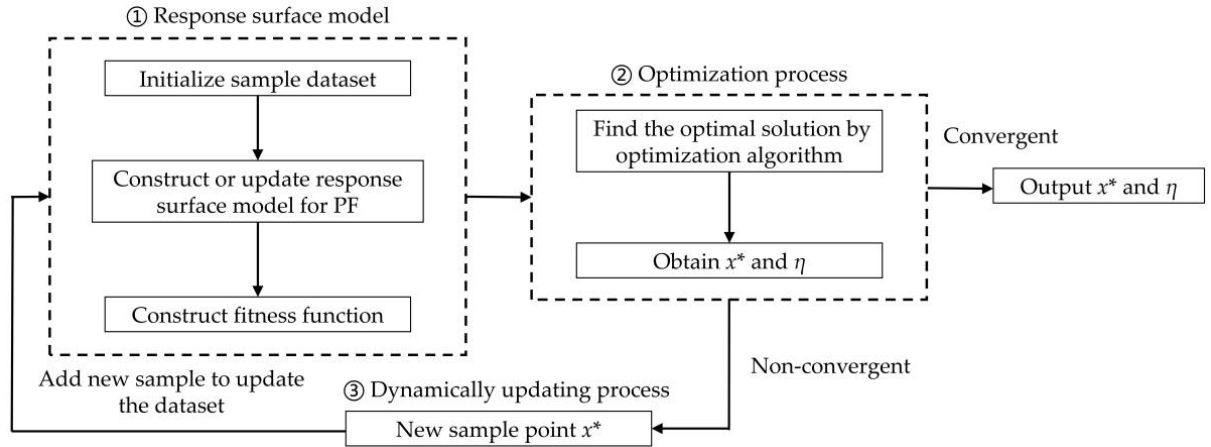
Figure 2. Framework of the proposed method.